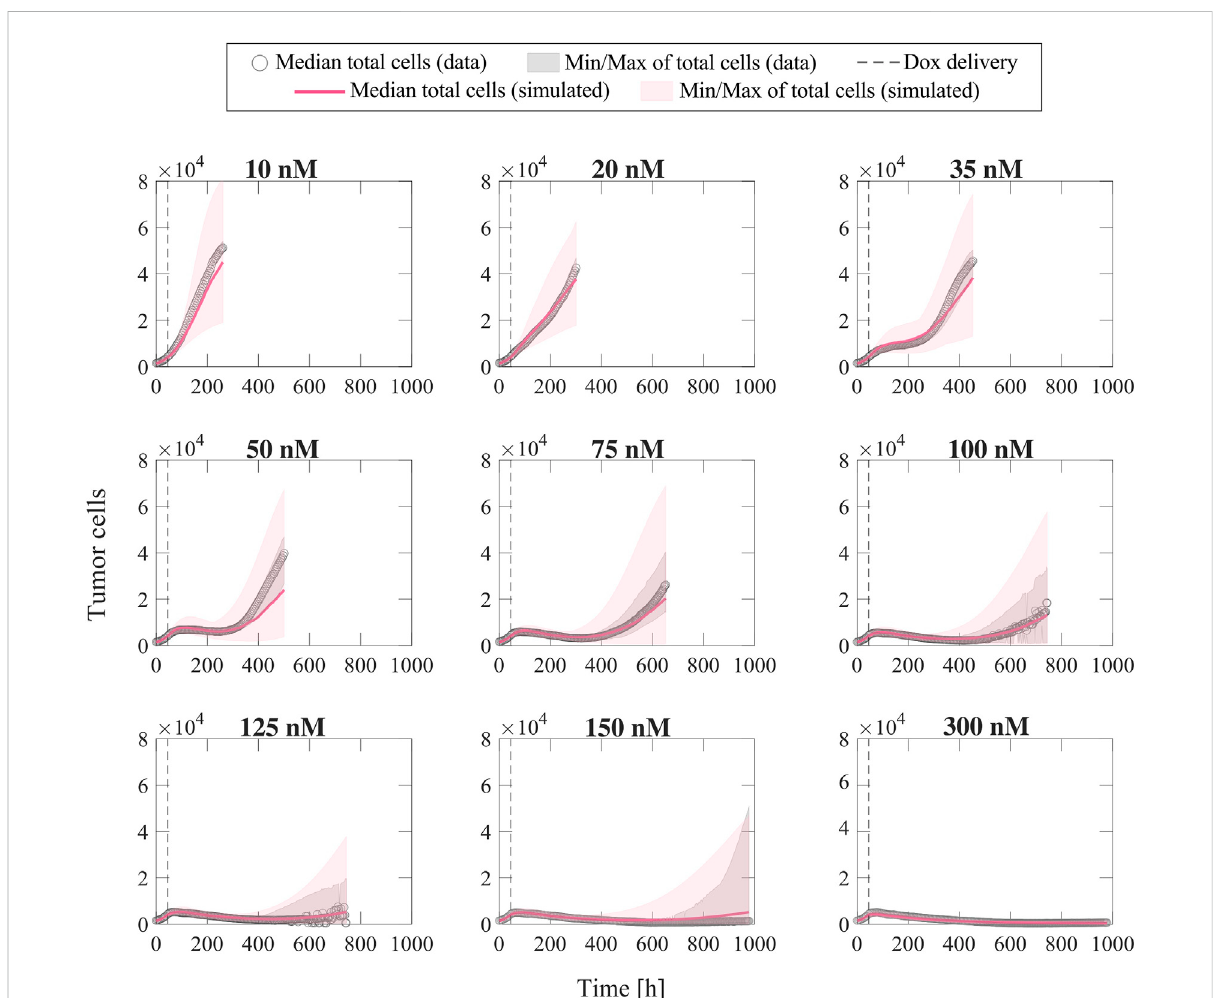
FIGURE 4 Comparison of simulated tumor cell population growth based on empirical parameter formulas with respect to experimental data for varying doxorubicin concentrations. We sampled the 95% con fi dence intervals for the fi tted empirical parameter formulas in Figure 3 using Latin hypercube sampling to obtain 200parameter combinations foreach doxorubicin concentration, with which wecarriedout corresponding simulations withthe single-dose model. The median and range of the model simulations are plotted with the median and range of the experimental data from Experiment 1 (Table 1) at each time point for comparison. The median of the experimental data is shown with gray circles, and the range of the experimental data is represented with gray shaded regions. The median of the model simulations is plotted as a pink solid line, and the range of the simulations is shown as pink shaded regions. The time of doxorubicin delivery is represented with a vertical grey dashed line. We observe that our fi tted parameter formulas from Figure 3 can reproduce a wide range of tumor cell population dynamics, including those observed in the varying concentration datasets (Experiment 1, Table